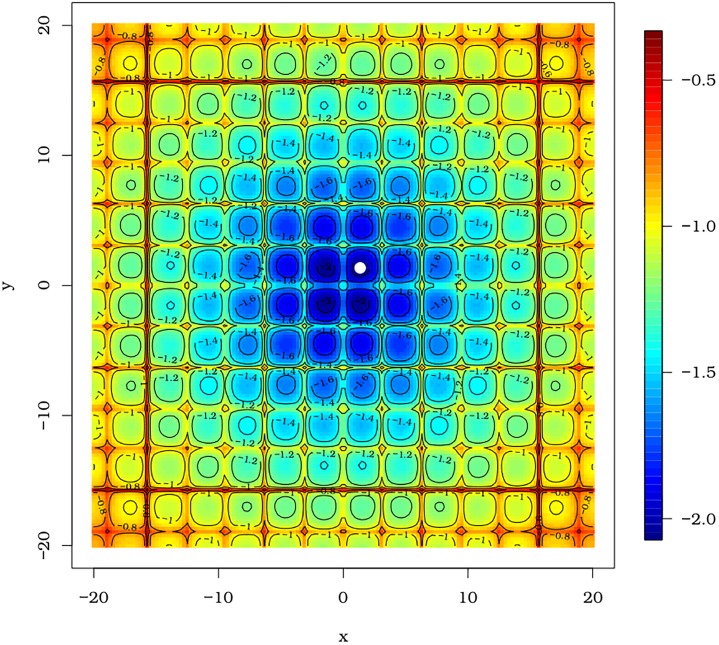
Levels of the Cross-in-tray function.The white point is the minimum value obtained by the pso() function.